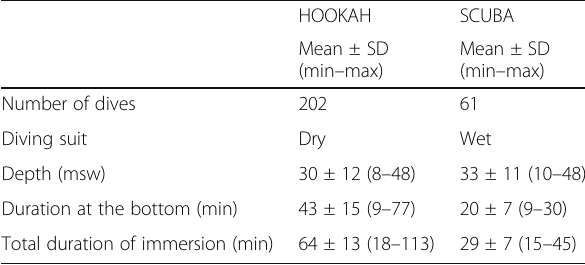
Table 1 Characteristics of the dives studied